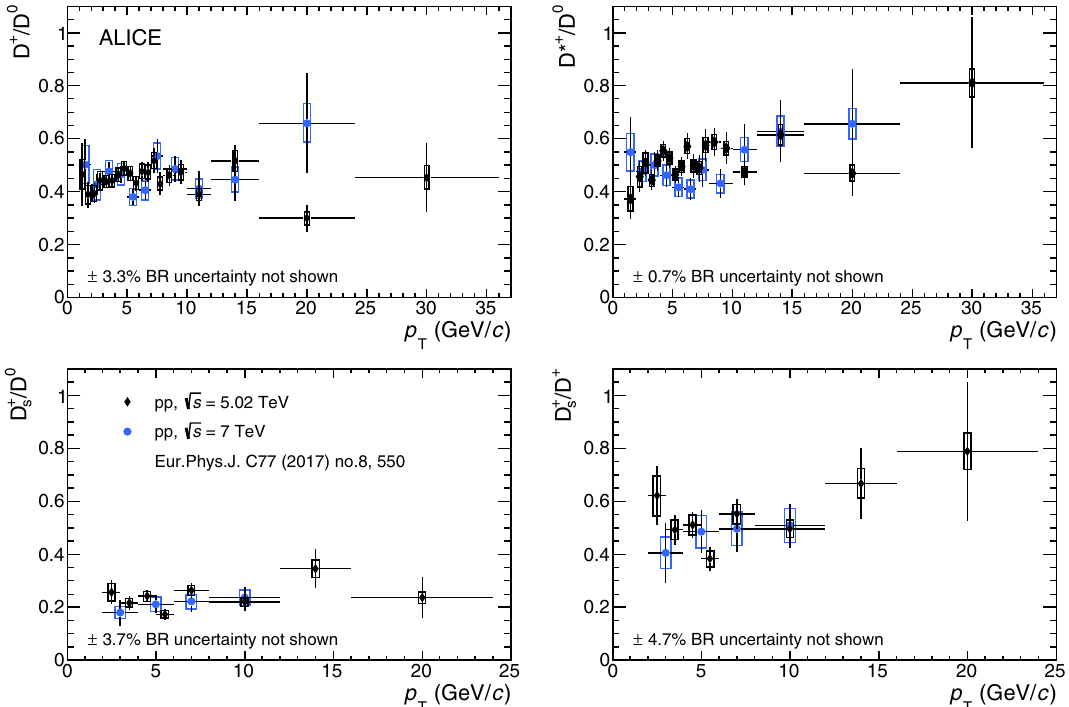
√ √ s = 5 . 02 TeV and s = 7 TeV